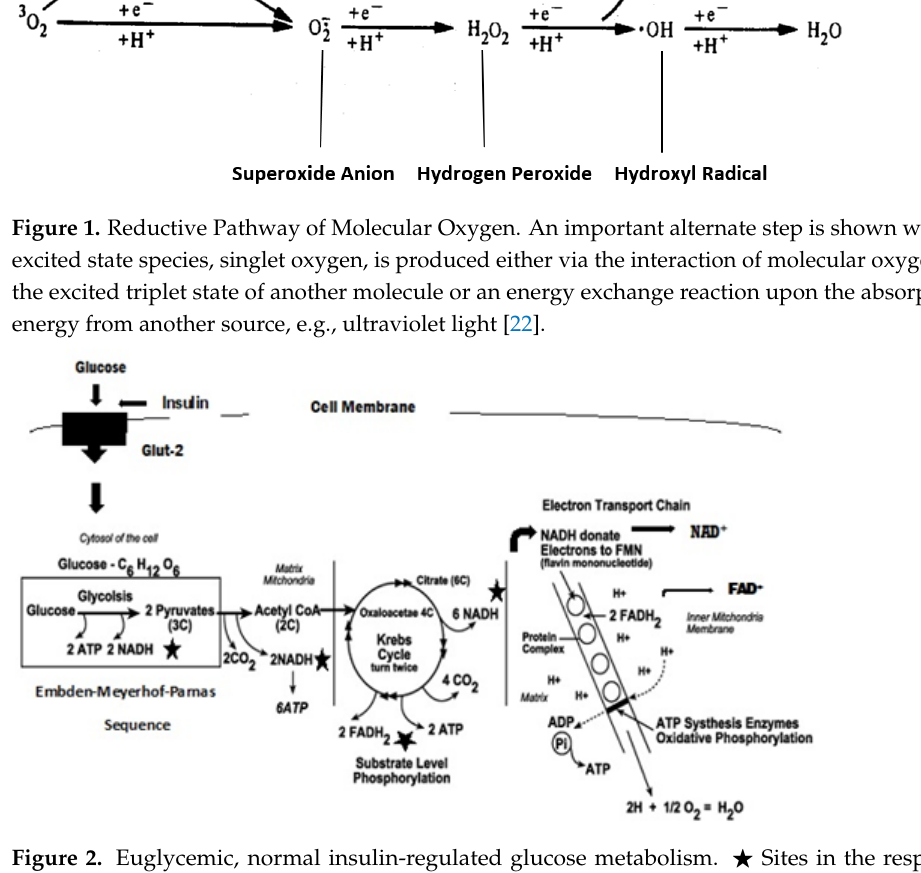
Figure 2. Euglycemic, normal insulin-regulated glucose metabolism. (cid:70) Sites in the respiratory sequence at which low levels of superoxide may be formed through the transfer of electrons via the electron transport chain (ETC). Once glucose moves into the cell, it is retained though phosphorylation by hexokinase and ATP. The product, glucose-6-phosphate, is phosphorylated again to form fructose-1,6-diphosphare prior to splitting into 3-carbon fragments. These 3-carbon fragments are converted to pyruvic acid. All these reactions occur in the cell cytosol. Pyruvic acid enters the mitochondrial matrix and is decarboxylated and oxidized to the 2-carbon, acetyl CoA. This oxidization results in the formation of 2 NADH and the potential formation of low levels of superoxide as the electrons are passed through the ETC. Acetyl CoA enters the Krebs cycle by condensation onto oxaloacetate to form citrate that is decarboxylated and oxidized in the Krebs cycle to form 6 NADH and 2 FADH. These are potential ROS sources as the electrons are passed through the ETC. Flavin mononucleotide (FMN) is a highly oxidative cofactor associated with NADH and FADH dehydrogenases that can accept two electrons to become reduced. The figure depicts GLUT-2, an intestinal glucose transporter that allows effective glucose transport at high glucose concentrations. There are now a wide range of glucose transporters that are tissue specific [23].